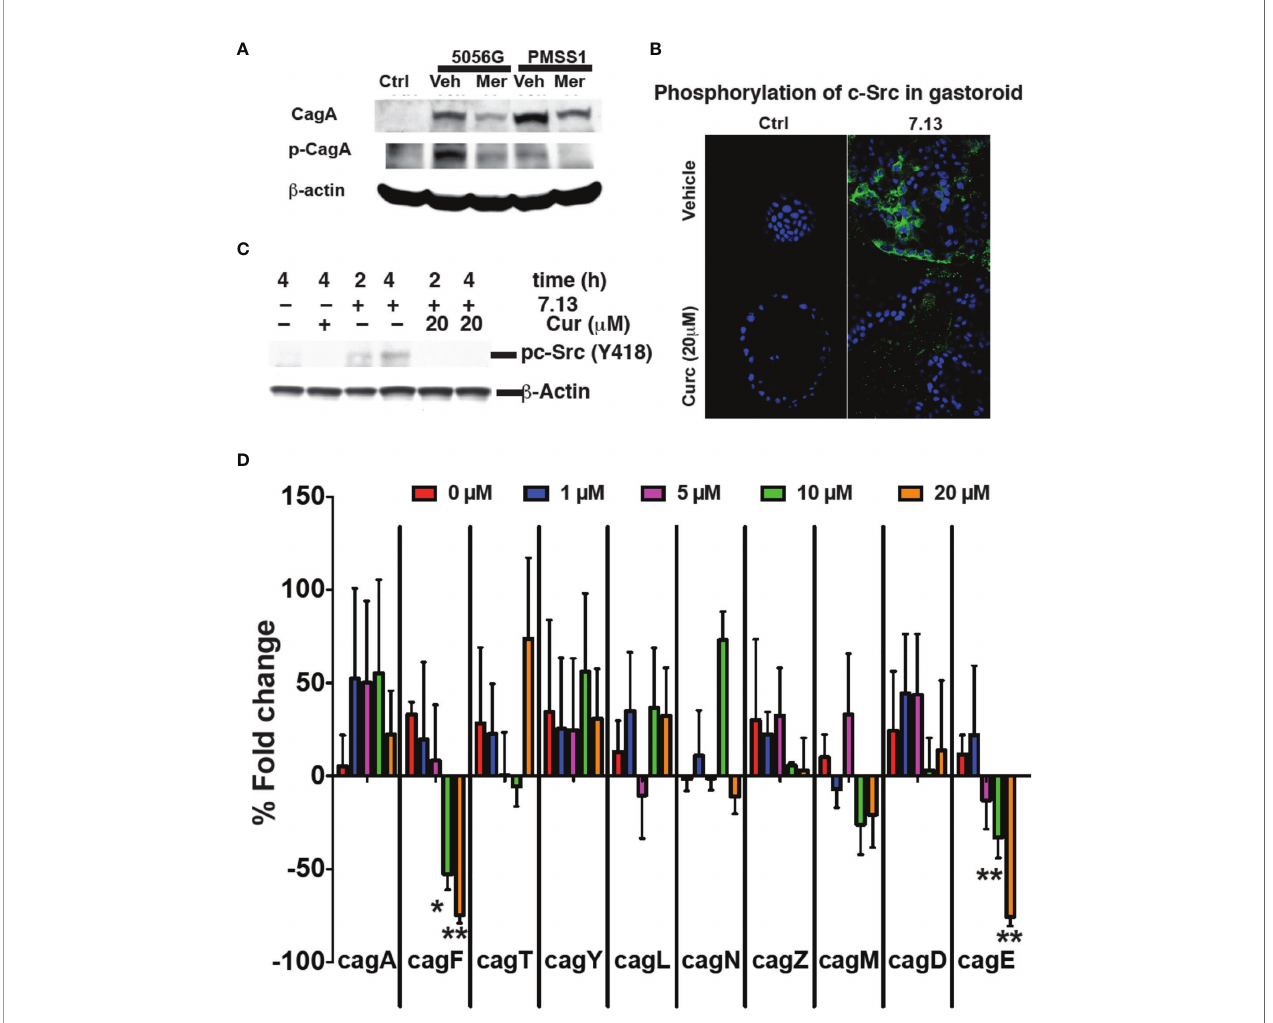
FIGURE 5 | Curcumin prevents cagA phosphorylation. (A) Gastric epithelial cells were infected with H. pylori strains PZ5056G or PMSS1 in the absence or presence of Meriva (20 m M). CagA and phospho-CagA were determined by Western blotting using b -actin as loading control. Representative results from three independent experiments are shown. (B) Mouse stomach glands were isolated and plated in matrigel in the presence of growth factors. H. pylori was grown for 6 h with or without Meriva, harvested, and microinjected into the lumen of the gastroids. Infected gastroids were cultured and stained using an anti-phospho-cSrc antibody followed by Alexa Fluor 488-conjugated anti-rabbit IgG antibody (green). Nuclei were stained with DAPI (blue). (C) Western blot analysis of c-Src phosphorylation in stomach organ cultures used in panel (B) . (D) Q-PCR analysis (% fold change) of the expression of the genes encoding for the Cag proteins A, F, T, Y, L, N, Z, M, D, and E in H. pylori (Shaffer et al., 2011; Frick-Cheng et al., 2016) treated with different concentrations of Meriva. *P ≤ 0.05; **P ≤